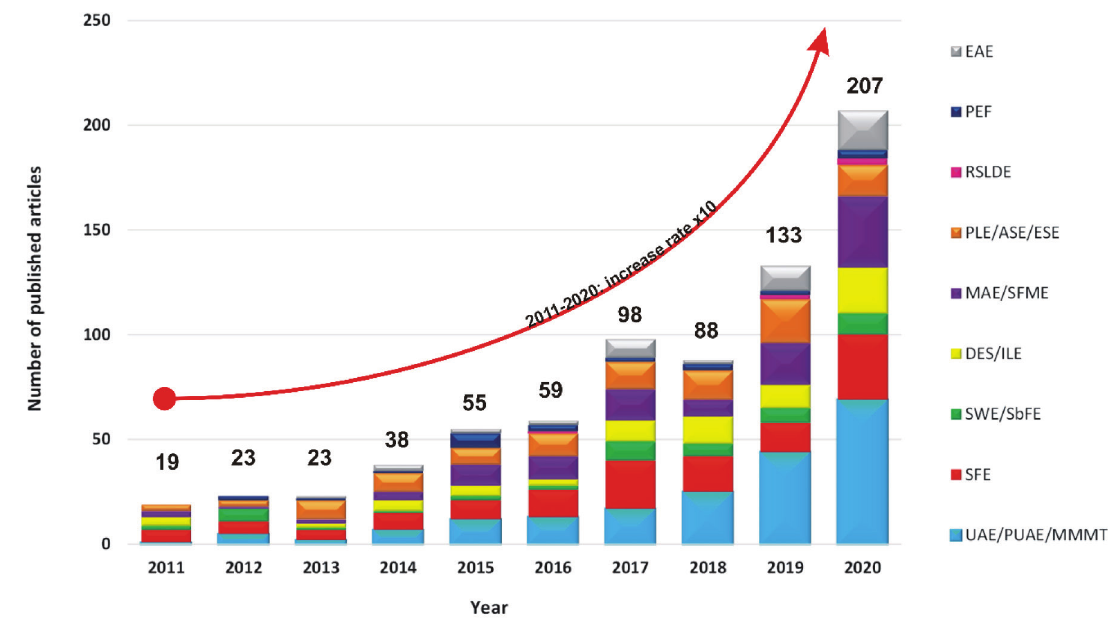
Fig. 1 – Number of original articles on the application of green extraction technologies on agro-industrial by-products (source Scopus ® , 30/01/2021; for the abbreviations, see the list at the end of the